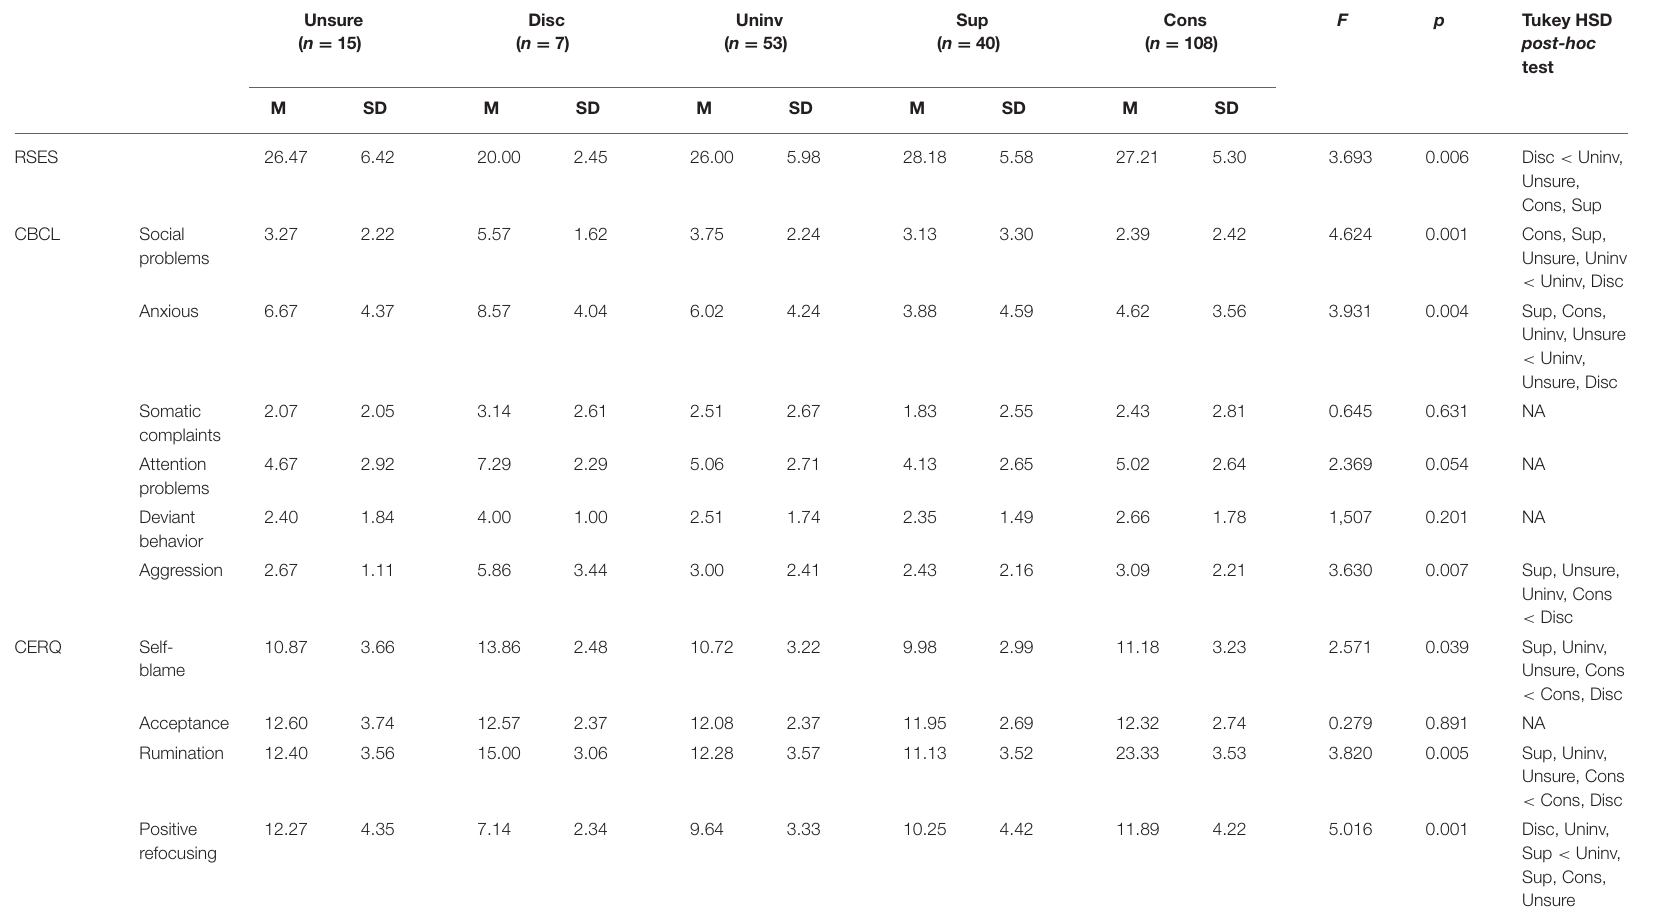
TABLE 8 | Comparison of the five H-UMICS (relational identity) clusters on the measured variables; results of